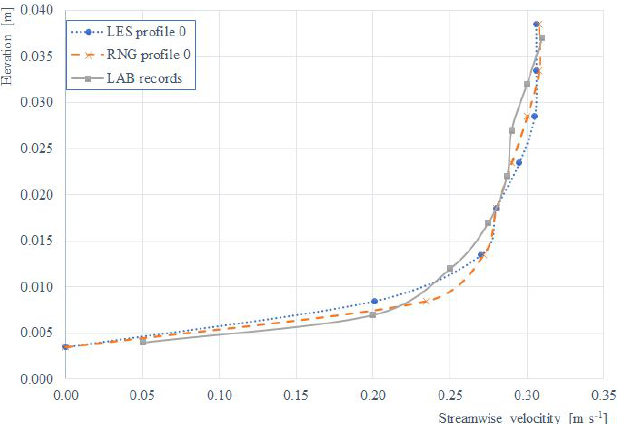
Figure 4. Comparison of the computed and recorded values in the laboratory ( X-velocity